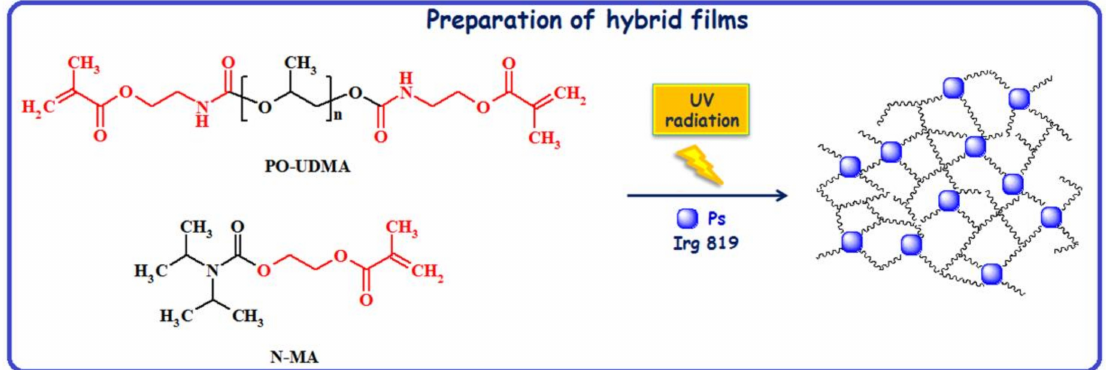
Scheme 1. Synthesis path towards ZnO or ZnO-SnO 2